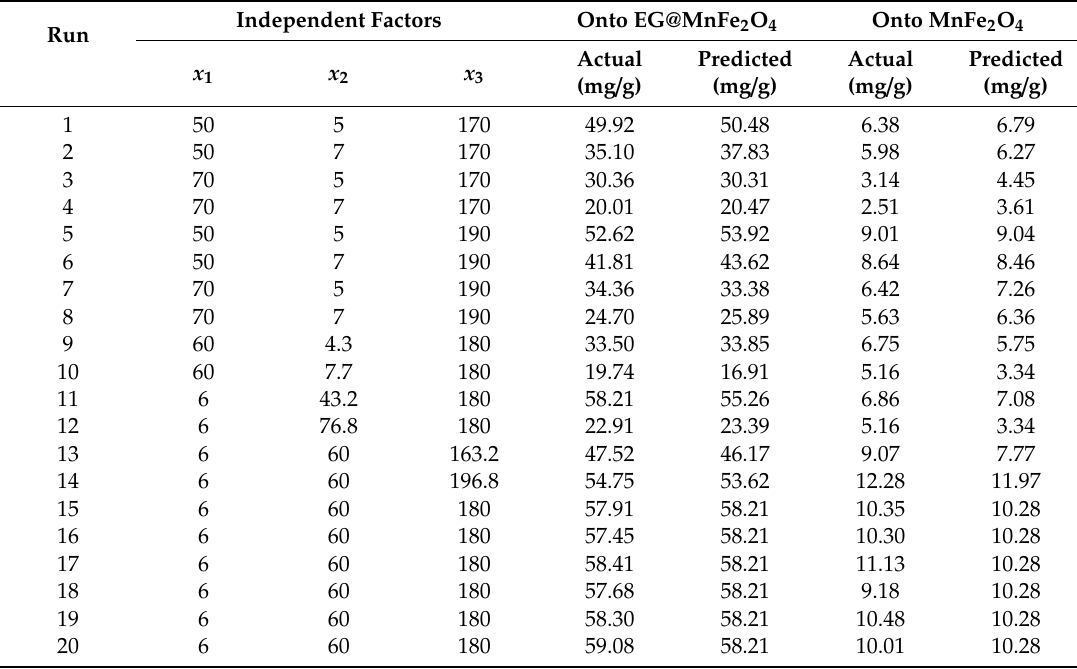
Table 4. Matrix of observed and predicted values for CR adsorption